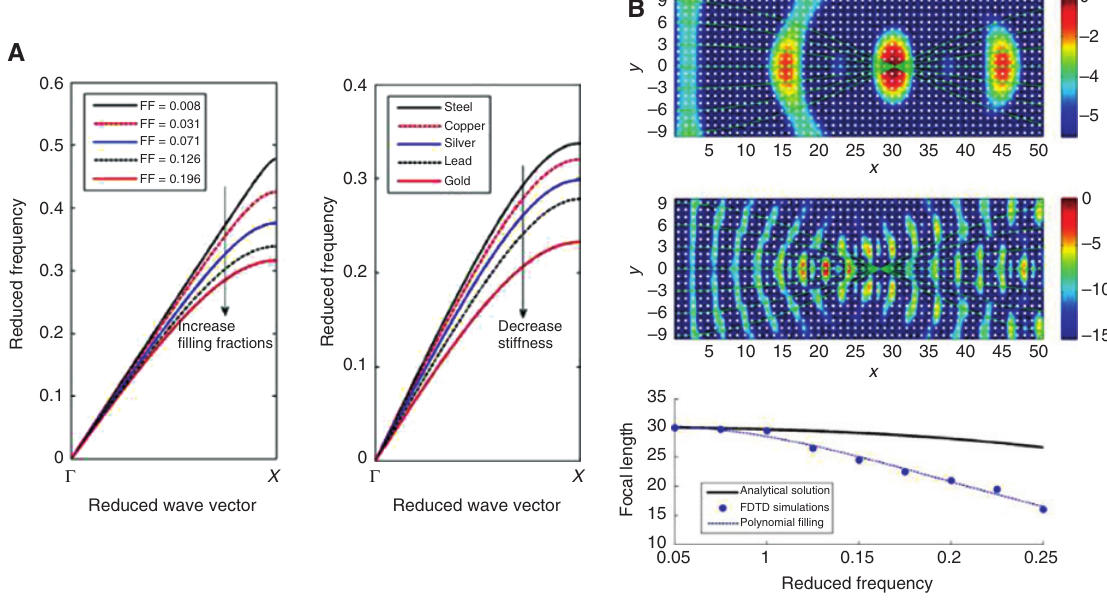
Figure 6: GRIN phononic crystals for bulk elastic waves. (A) Left: The first shear-vertical (SV) mode of bulk elastic wave along the Γ X for varying the filling fractions of steel cylinders embedded in epoxy. The arrow indicates the increasing of the filling fraction. Right: Same band diagram but for phononic crystals made of different solid material inclusions in epoxy with a fixed filling fraction as 0.126. The arrow indicates the decreasing of stiffness. (B) The finite difference time domain (FDTD) simulated SV wave propagations in a phononic crystal whose inclusions are made of different materials embedded in epoxy at two different frequencies. The calculated and simulated focal lengths as a function of frequency are also plotted as solid line and dotted line, respectively